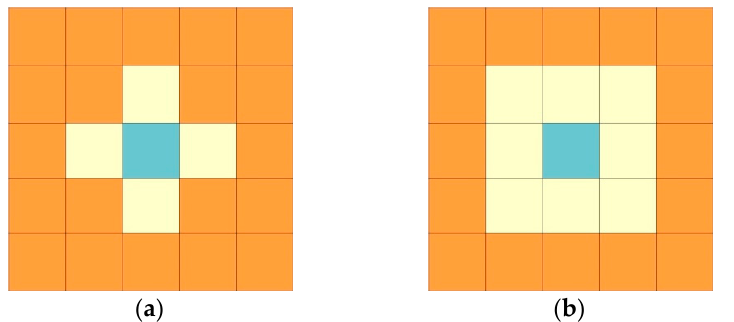
Figure 2. Types of neighbourhood in the cellular automata space: ( a ) von Neumann (4 nearest cells); ( b ) Moore (8 nearest cells).